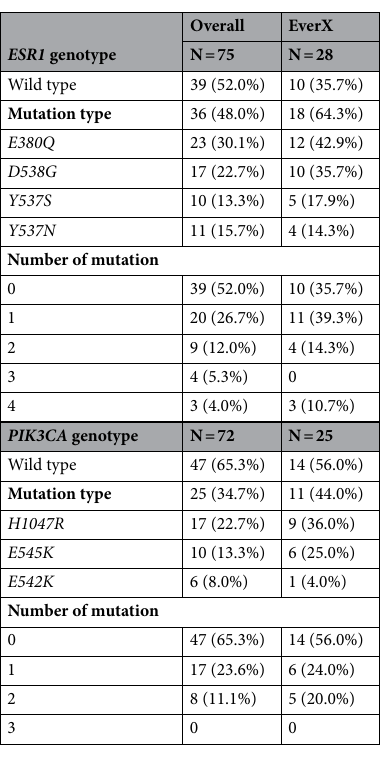
Table 2. Prevalence of ESR1 and PIK3CA mutations in overall population and EverX subpopulation.